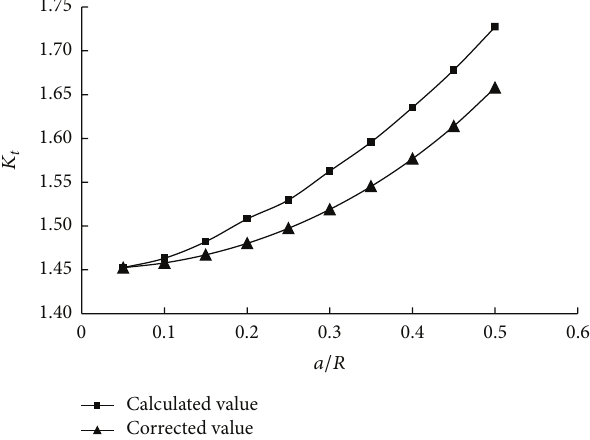
Figure 8: Variations of SCF with 𝑎/𝑅 for 𝑎/𝑏 = 0.5